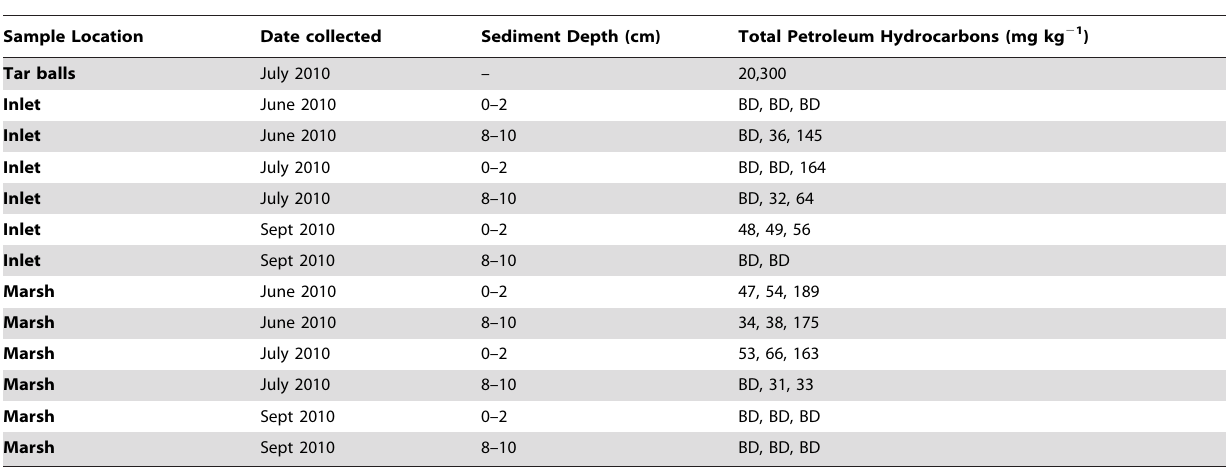
Table 2. Total petroleum hydrocarbons (TPH) detected in one or replicate samples.